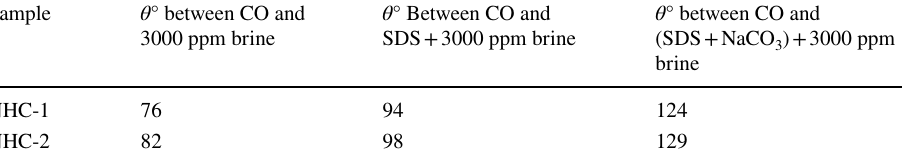
Table 4 Contact angle of core samples